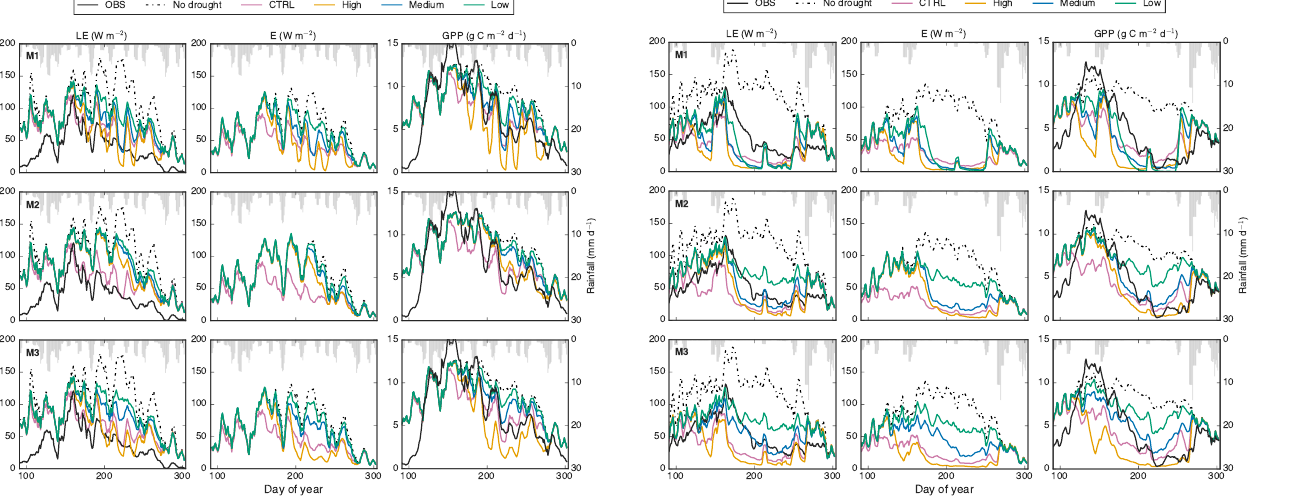
Figure 5. A comparison of the observed (OBS) and modelled la- tent Heat (LE), transpiration ( E ) and gross primary productivity (GPP) at the Roccarespampani site during 2003. Simulations show the control (CTRL) and the three parameterisations that represent a spectrum of behaviour ranging from a high to low drought sensitiv- ity, and the tested methods to obtain a weighted estimate of soil wa- ter potential ( (cid:57) S ) across CABLE’s soil layers (M1–M3). M1 uses a root-biomass weighted soil water content converted to (cid:57) S , M2 calculates (cid:57) S by integrated soil water content over the top 1.7m of the soil, and M3 is calculated using a dynamic weight across soil layers. The data have been smoothed with a 5-day moving window to aid visualisation and the grey bars show daily